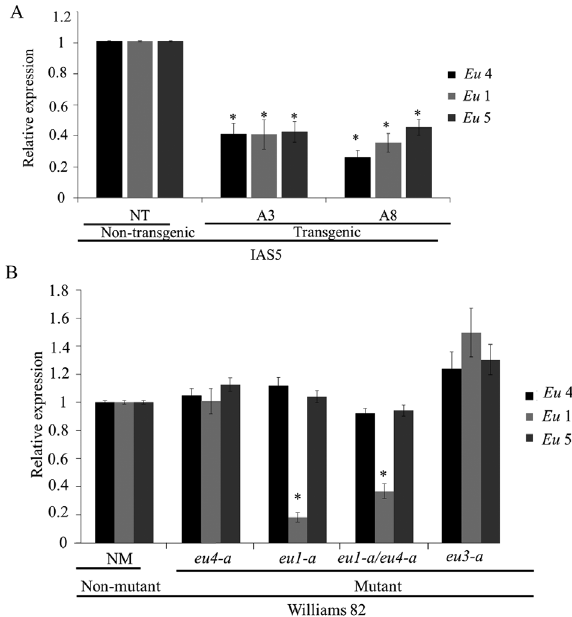
Figure 1 - Transcript levels (RT-qPCR) of urease-encoding genes ( Eu 4, Eu 1, Eu 5)inrootsoftwo-week-oldplants . (A)Twoindependenttransgen- ic events (A3 and A8) and non-transgenic plants (NT, control) from cv. IAS5. (B) Williams82 non-mutant (NM, control) and eu4-a , eu1-a , eu1-a/eu4-a and eu3-a mutants. The bars represent mean (cid:2) SD of two non-transgenic plants, 10 transgenic plants from each event, two non-mutant plants and 10 plants from each mutant. Transcripts level of Eu 4, Eu 1 and Eu 5 detected in non-transgenic or non-mutant plants were used to normalize transcript accumulation in transgenic or mutant plants, respectively. F-Box and Metalloprotease reference genes were used as in- ternal controls to normalize the amount of mRNA present in each sample. * indicates that the mean of each gene is significantly different from the control ( t -test, p <